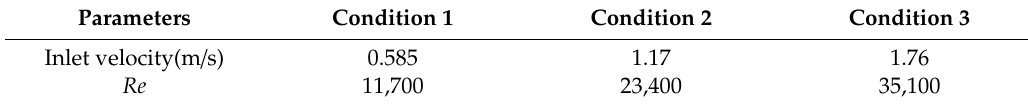
Table 1. Computational conditions of submerged impinging